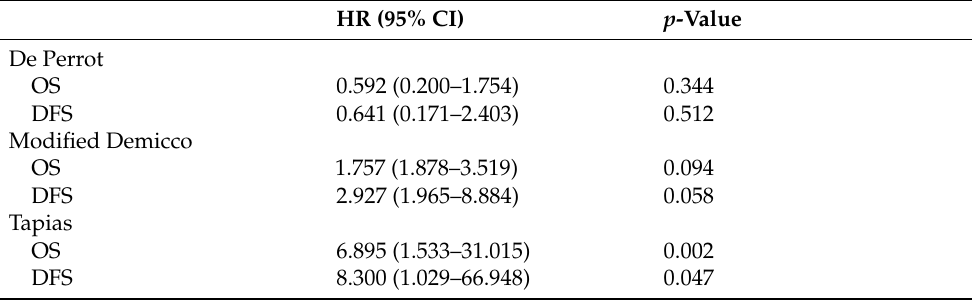
Table 7. Univariate analysis for OS and DFS, risk stratification